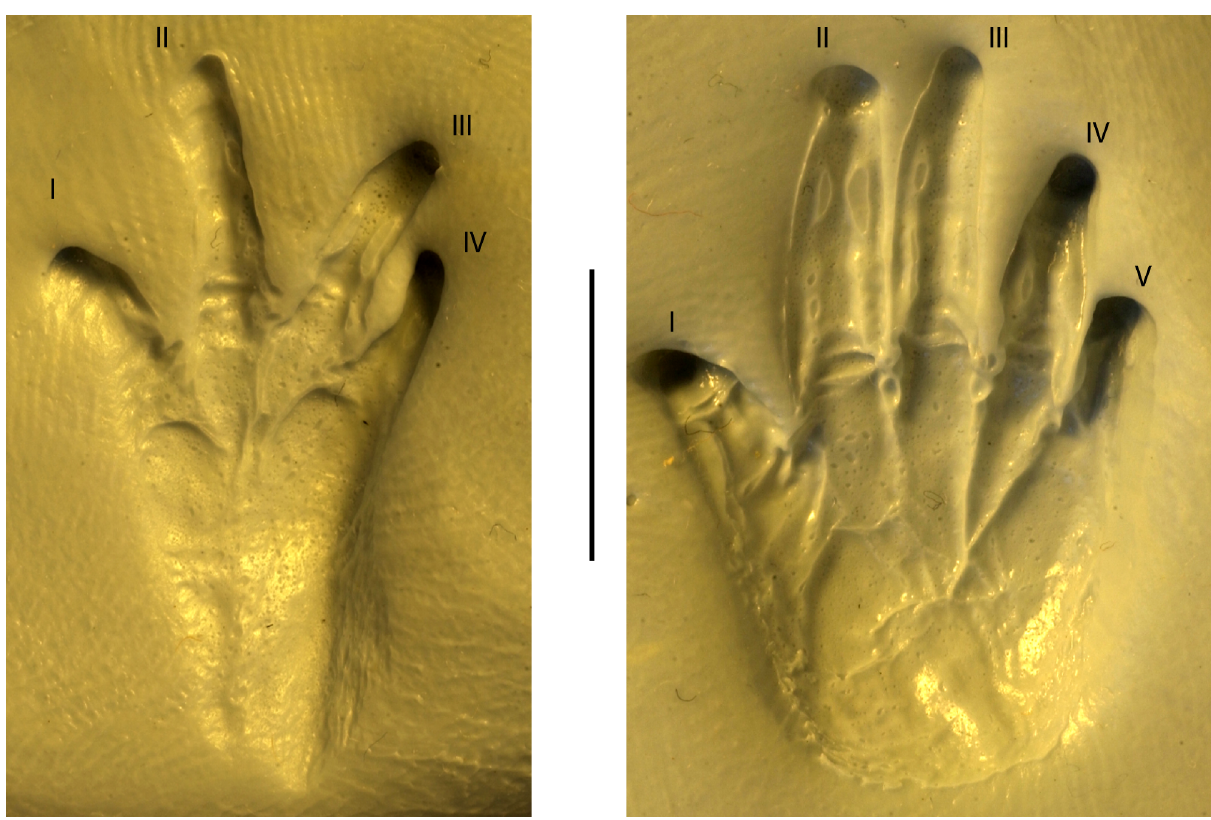
Figure 9. Salamander manus and pes surface morphology. Photographs show the impressions left by the undersides of the right manus and pes of the salamander Dicamptodon ensatus (UMMZ 135631). Roman numerals indicate digit number. Scale equals 1 cm.